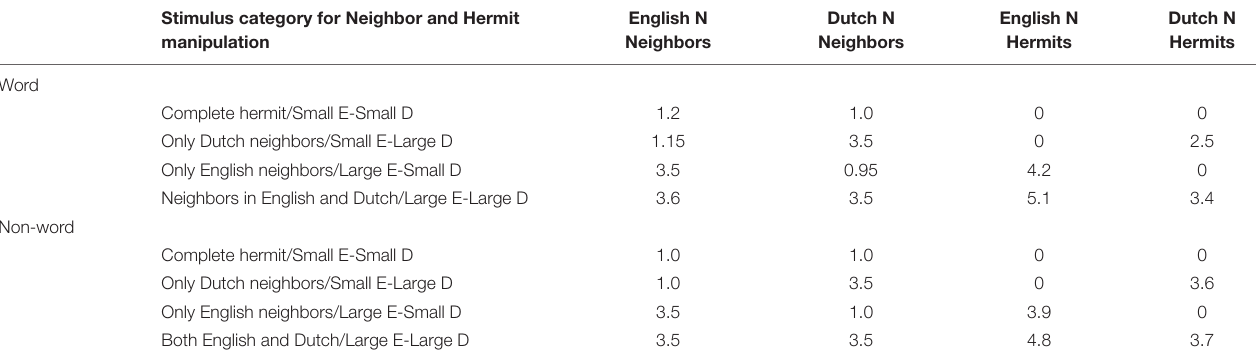
TABLE 1 | Stimulus characteristics in the neighbor manipulation (van Heuven et al., 1998, Experiment 4; Experiment 1) and the hermit manipulation (Experiments 2 and 3). Stimulus category for Neighbor and Hermit manipulation